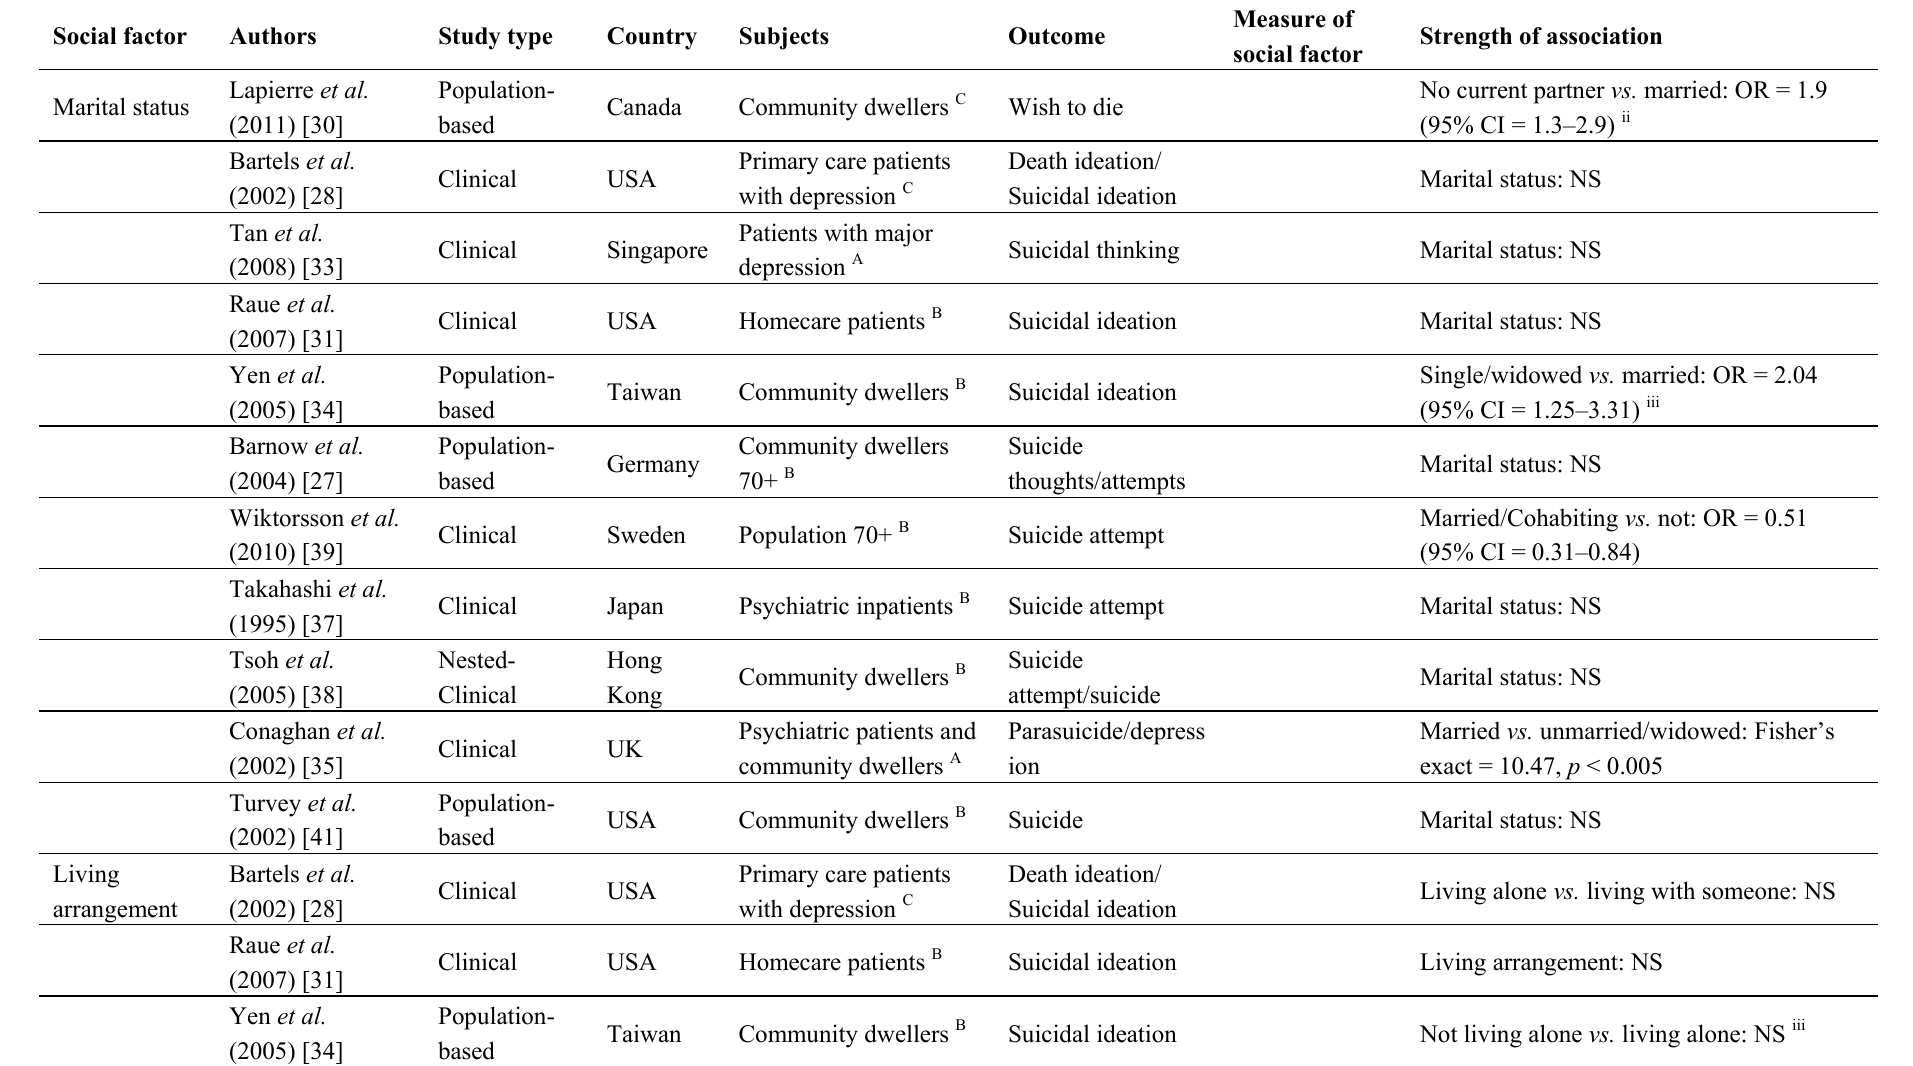
Table 1. Review findings summarized by social